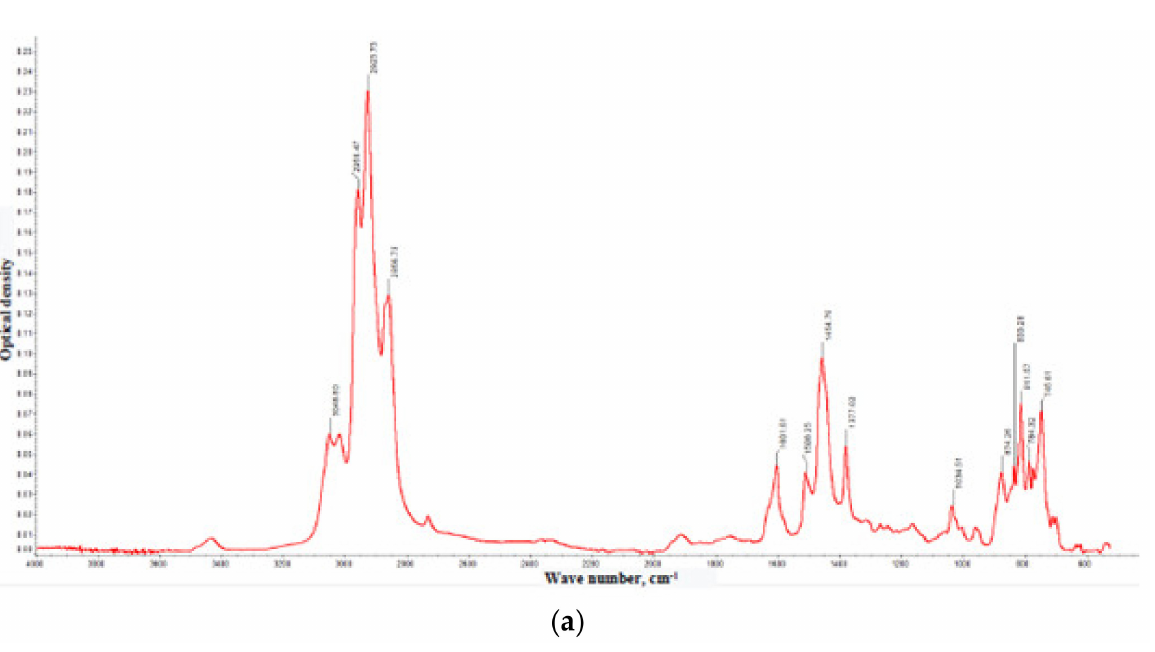
Figure 2. IR spectrum of the original gasoil.